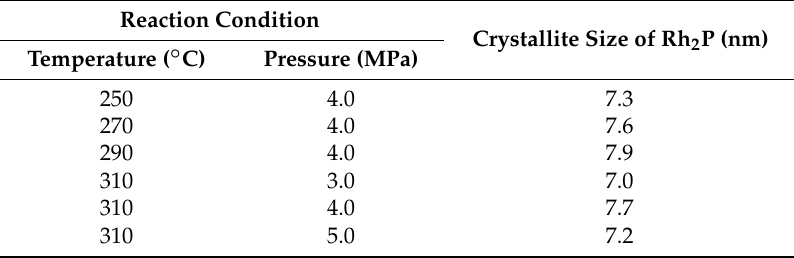
Figure 9. XRD patterns of Rh-P catalysts after the HDS of 4,6-DMDBT at different reaction pressures. Table 5. Crystallite size of Rh 2 P in Rh-P catalyst after the HDS of